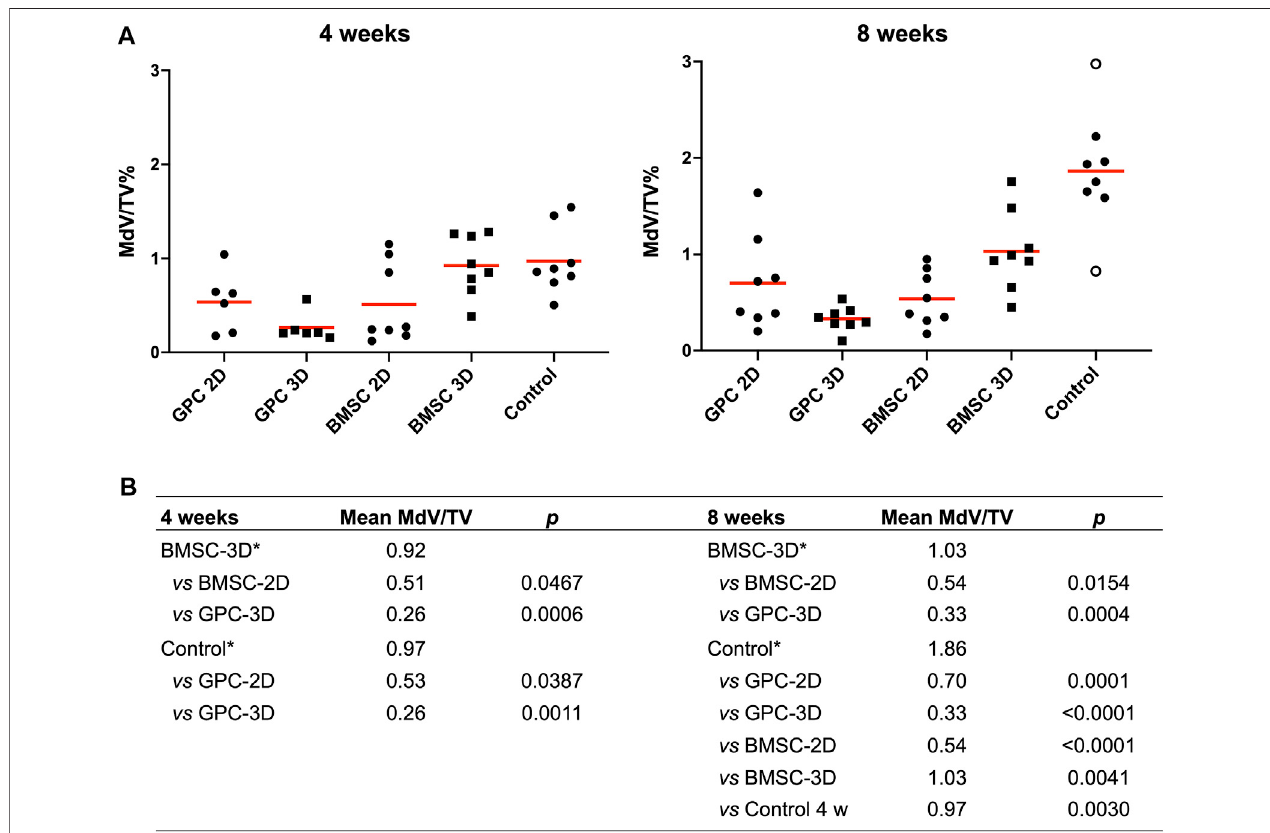
FIGURE 3 | Quanti fi cation of mineralization by μ CT. (A) Percentage mineralization in BMSC, GPC and control constructs (no cells) after 4 and 8 weeks; MdV/TV, mineralvolume/totalconstructvolume; datarepresent means;orepresentsoutliers. (B) Inter-groupcomparisonsshowingstatisticallysigni fi cantdifferences( p < 0.05);* reference group in the analysis (Kruskal-Wallis one-way